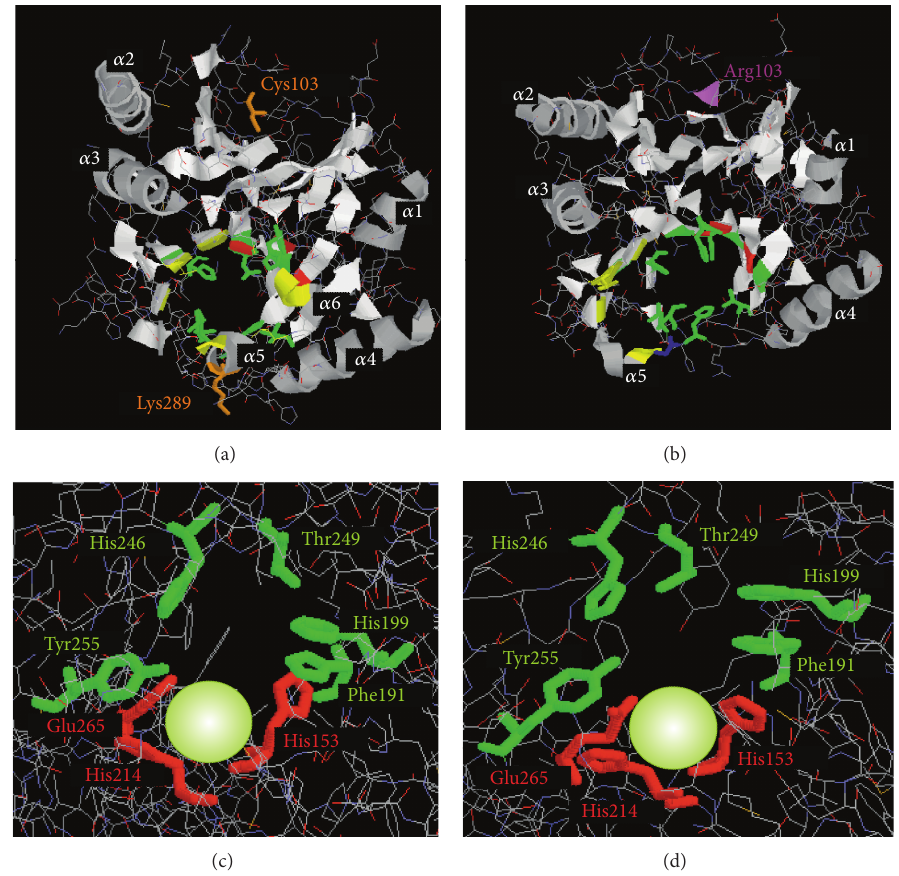
Figure 1: The deduced 3D structure of the wild-type and mutated C23O from Planococcus sp. S5. Top row localization of the molecular domains of wild-type (a) and mutant (b) protein. Bottom row predicted structure of the active sites of the wild-type (c) and mutant (d) protein. Fe atoms are shown as light green spheres; the three residues involved in ferrous ions coordination are shown in red and amino acid residues involved in substrate binding are shown in green. Amino acid residues forming the entrance to the active site pocket are shown in yellow.